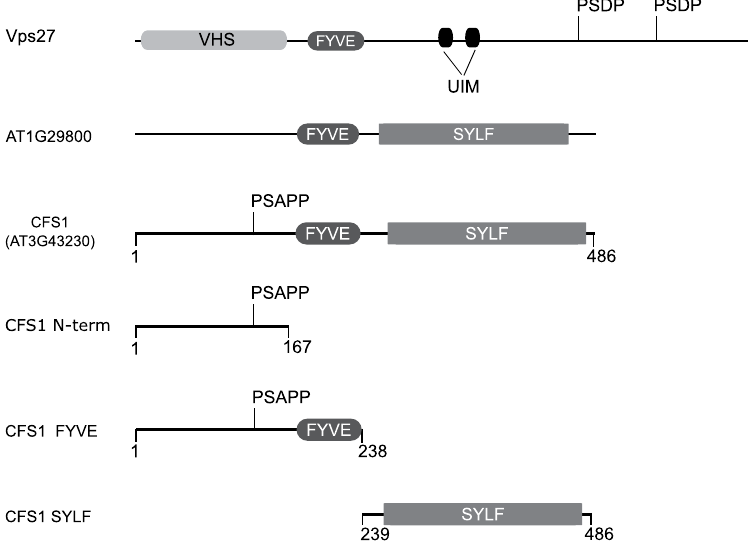
Figure 1. Schematic representation of Vps27p, AT1G29800 and CFS1. The yeast protein Vps27p contains a VPS27, Hrs and STAM (VHS) and FYVE domain, two ubiquitin-interacting motifs (UIM) and two PSDP motifs. AT1G29800 and CFS1 carry a FYVE and a SYLF domain, but only CFS1 contains the conserved PSAPP motif. CFS1 fragments used for localization and membrane interaction studies are shown. Numbers correspond to the amino acid